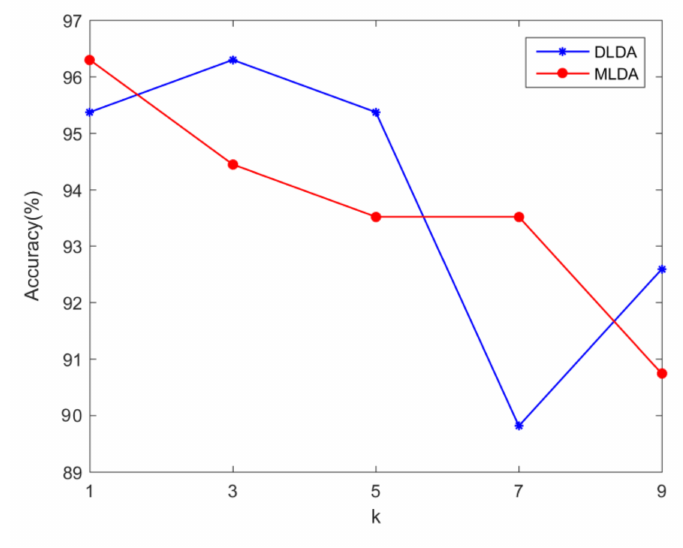
Figure 3. Accuracies of DLDA and MLDA at different k